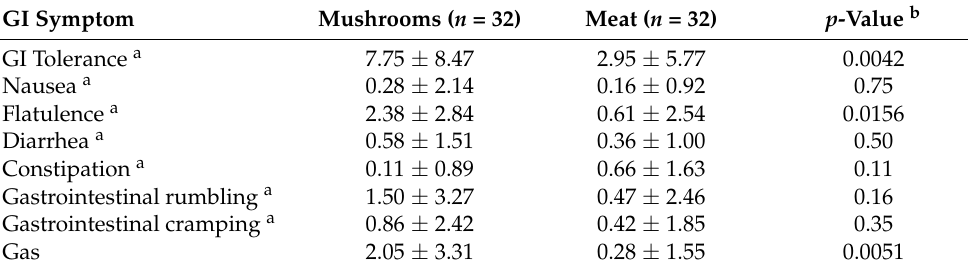
Table 5. Gastrointestinal tolerance measures day 2.